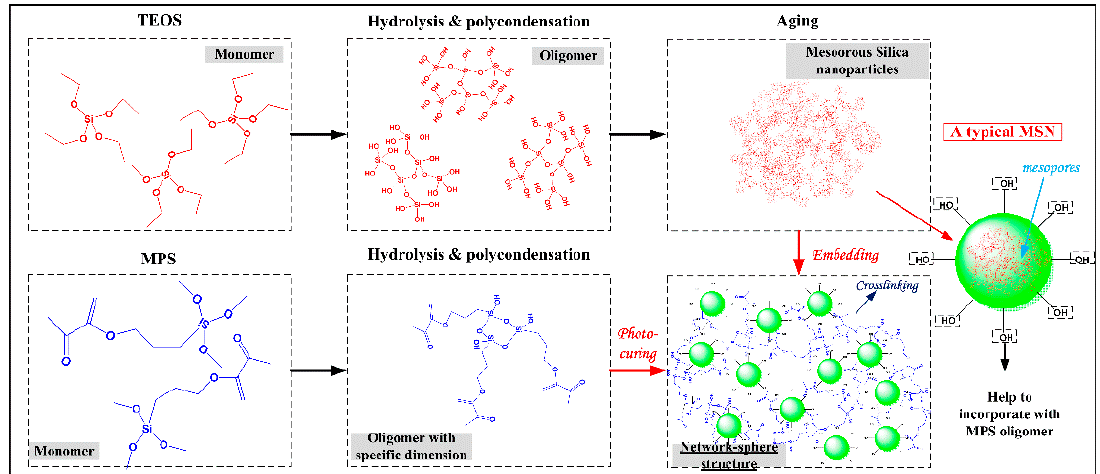
Figure 1. Schematic diagram of the designed network-sphere structure.